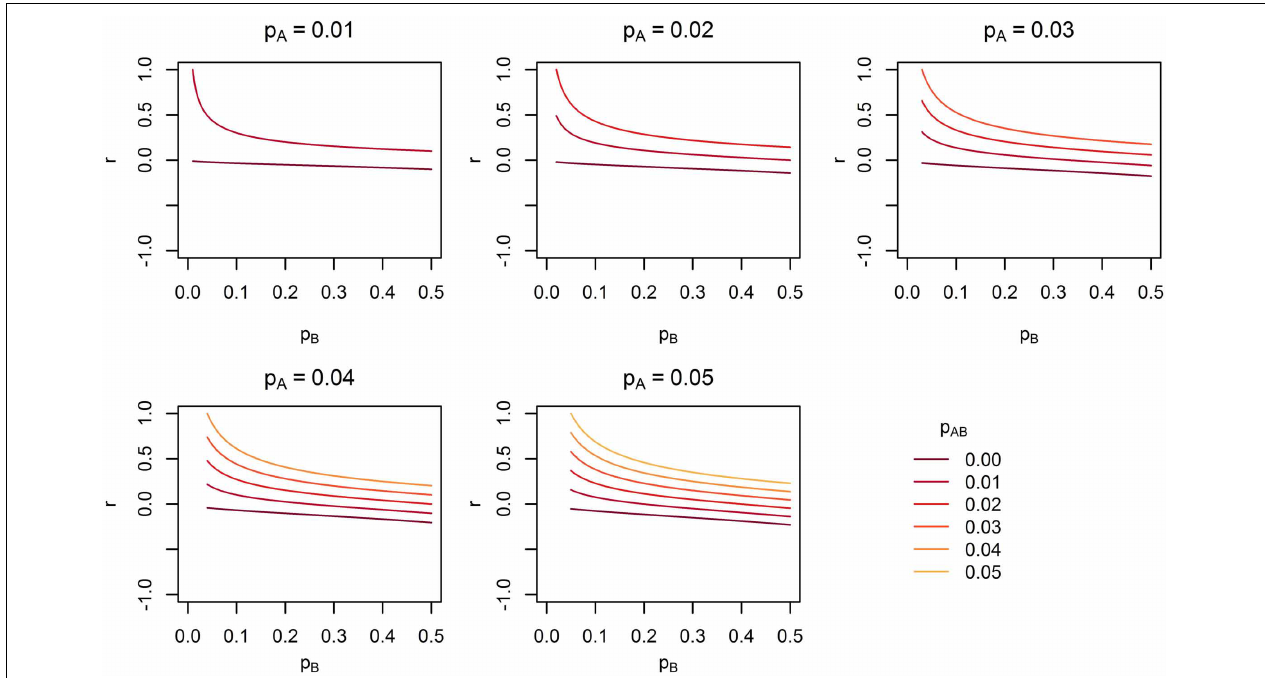
FIGURE 8 | The range of linkage disequilibrium measure r (correlation coefficient) with a given MAF of rare SNP A for range of MAF of SNP B . p A is the MAF of SNP A , p B is the MAF of SNP B , and p AB is the haplotype frequency consisting of rare alleles of SNP A and B